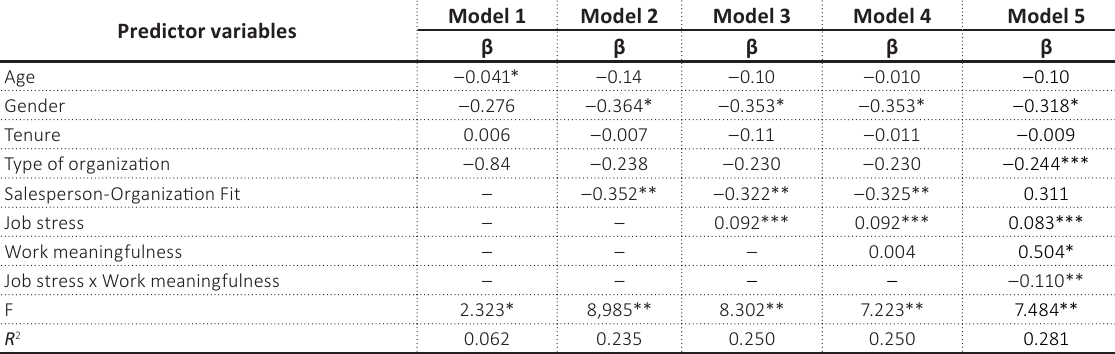
Table 1. Regression results predicting organizational